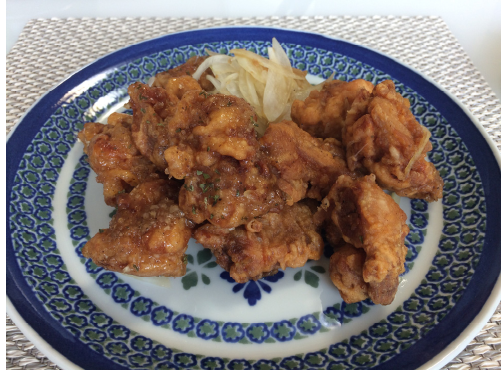
Figure A1. Ingredients: chicken, starch, egg white, frying powder and condiments: clear rice wine, sugar, starch syrup, soy sauce, garlic, ginger, lemon juice, soy, pepper, red chili paste, sesame oil; see recipe at: http://www.koreanbapsang.com/2014/03/dakgangjeong ‐ sweet ‐ crispy ‐ chicken_16.html.